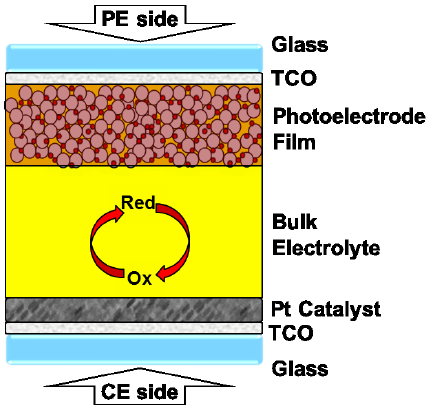
Figure 2. Optical layer structure of a typical DSC. PE: photo electrode; and CE: counter